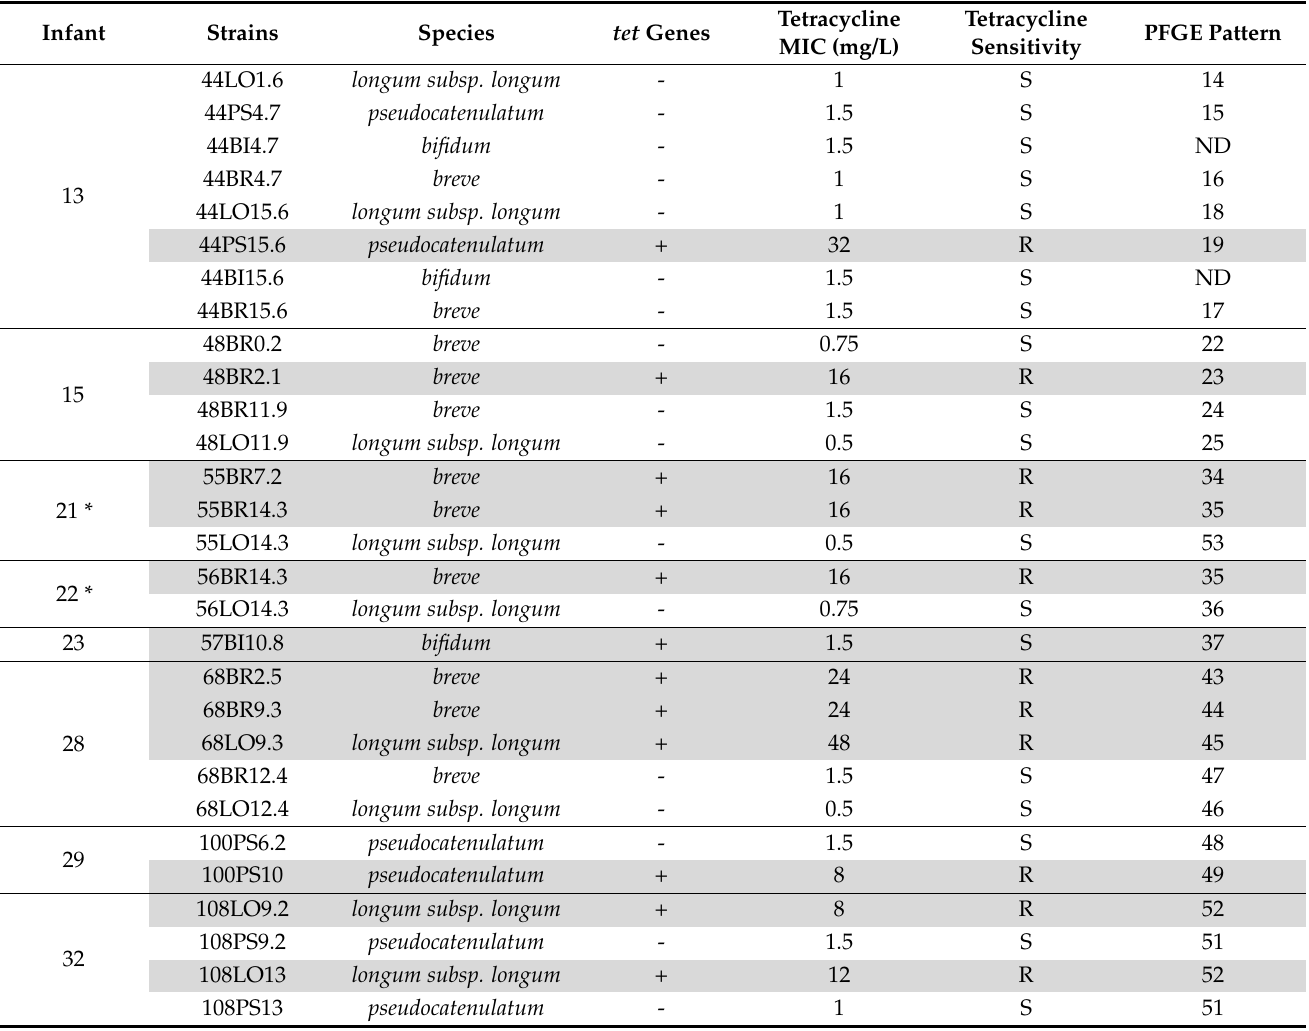
Table 3. Bifidobacteria isolated from the same infant with and without tet